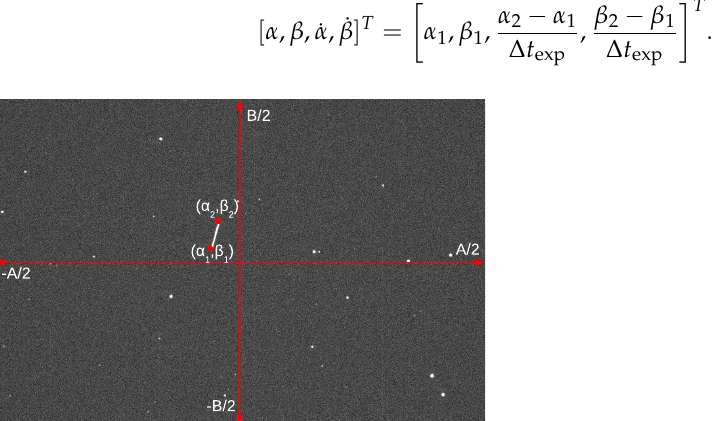
Figure 3. Image taken from the sidereal tracking of NORAD satellite 25,853, from the Mitre Corpo- ration. Horizontal/vertical arrowed red lines indicate angular axes, red dots indicate the satellite coordinate ( α 1 , β 1 ) at t k and ( α 2 , β 2 ) at t k + ∆ t exp